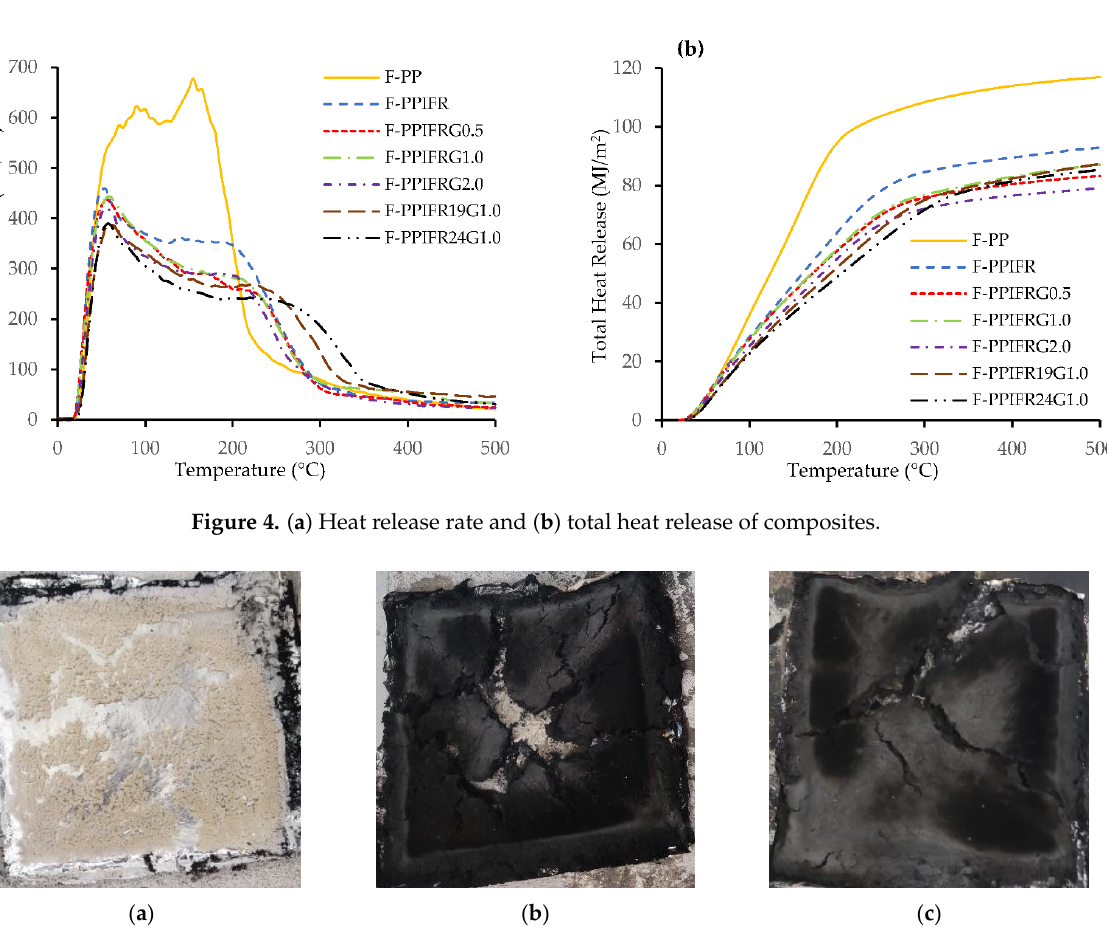
Figure 5. Char residue of ( a ) F-PP, ( b ) F-PPIFR and ( c ) F-PPIFRG1.0. Table 1. Cone calorimeter